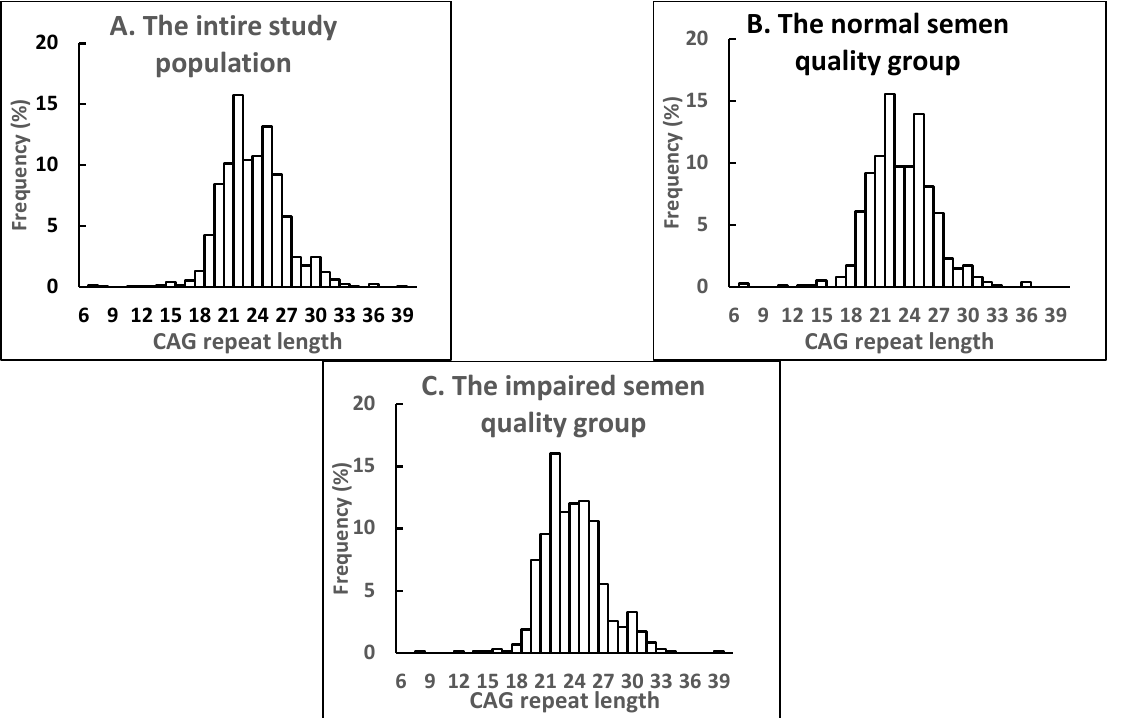
Figure 1. Frequency distribution of CAG repeat length in men of the entire study population ( A ), and the subgroups with normal ( B ) and impaired semen quality ( C ). Values are given as percentage of cases in relation to the respective number of men in each group. Table 1. Anthropometric, semen and hormonal characteristics of the entire Russian study popula- tion and subgroups with normal and impaired semen quality.